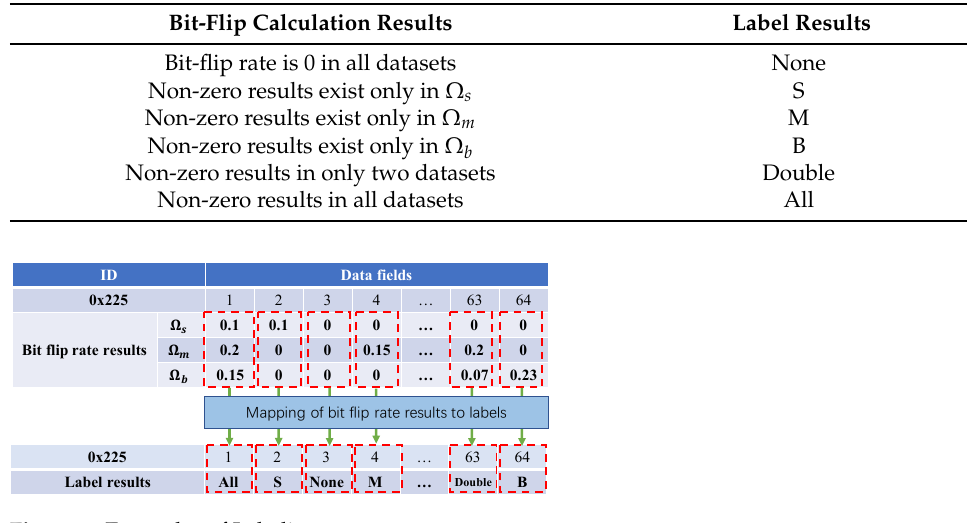
Figure 5. Examples of